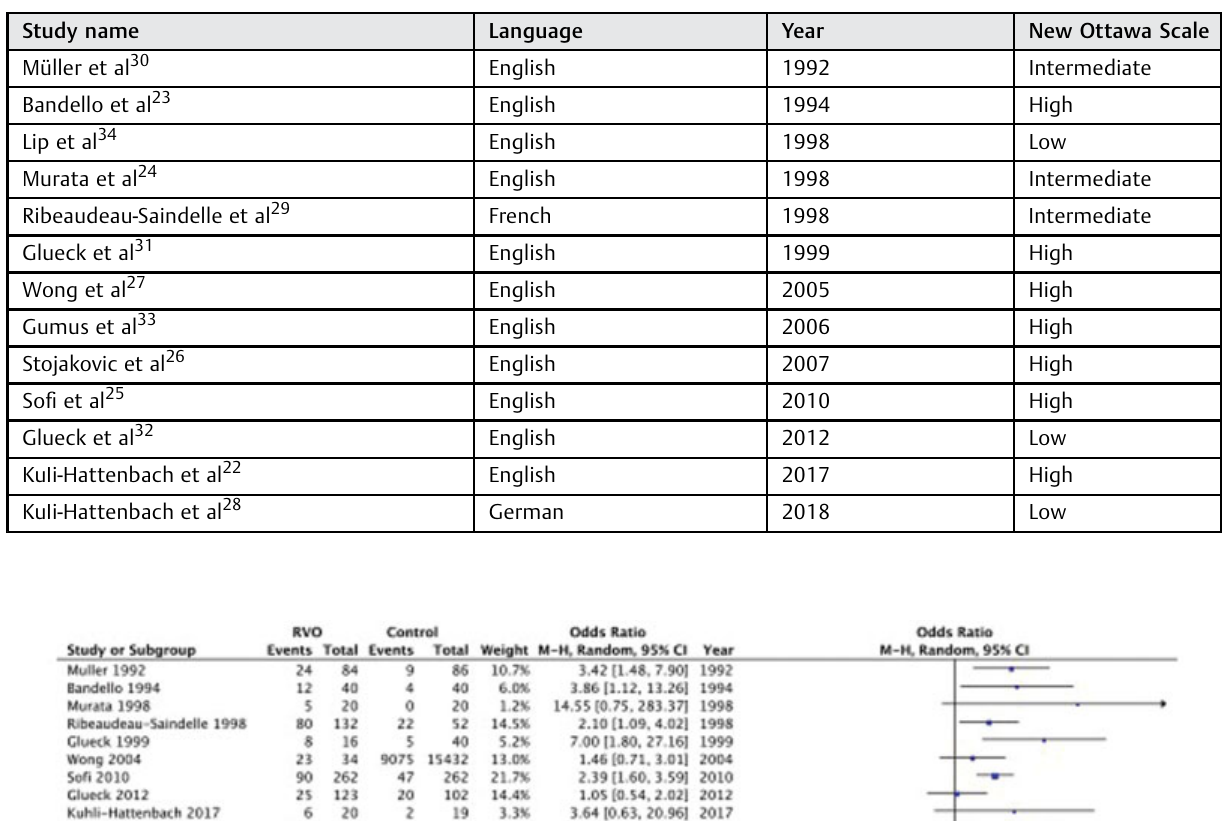
Table 2 Quality assessment of the studies included in the analysis